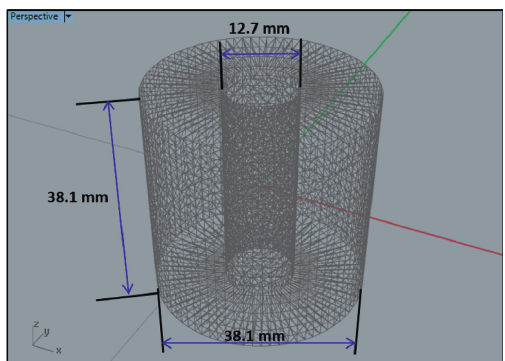
Figure 5: Dimensions of the TWC test sample for intact rock.